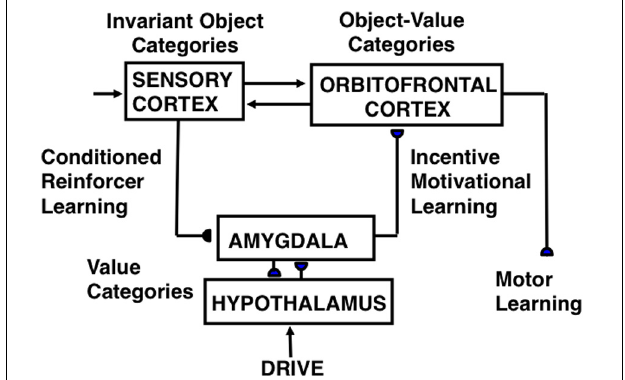
FIGURE 8 | CogEM (Cognitive-Emotional Motor) neural model circuits and their anatomical interpretation. The two successive stages of a sensory representation are interpreted to be invariant object categories in a sensory cortex—such as inferotemporal cortex in the case of vision—and